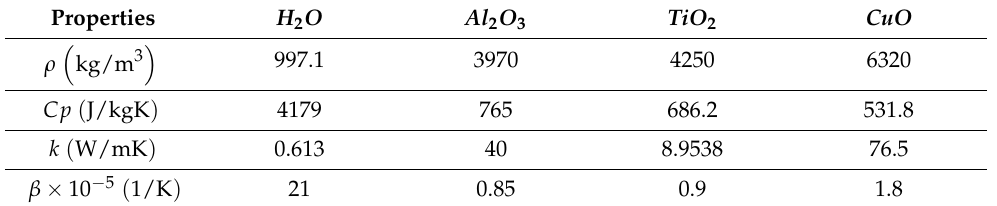
Table 1. Thermophysical characteristics of nanoparticles and base liquid are provided by (see [35]).